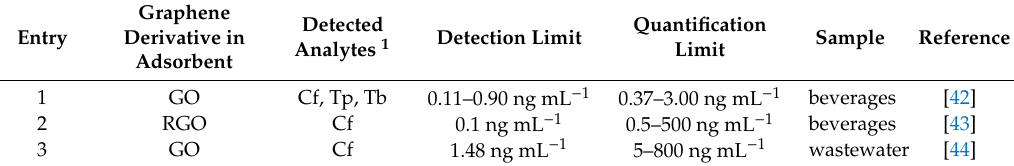
Table 2. Schematic overview on the use of GO and RGO as adsorbents for natural methylxanthynes determination and quantification in real samples (see